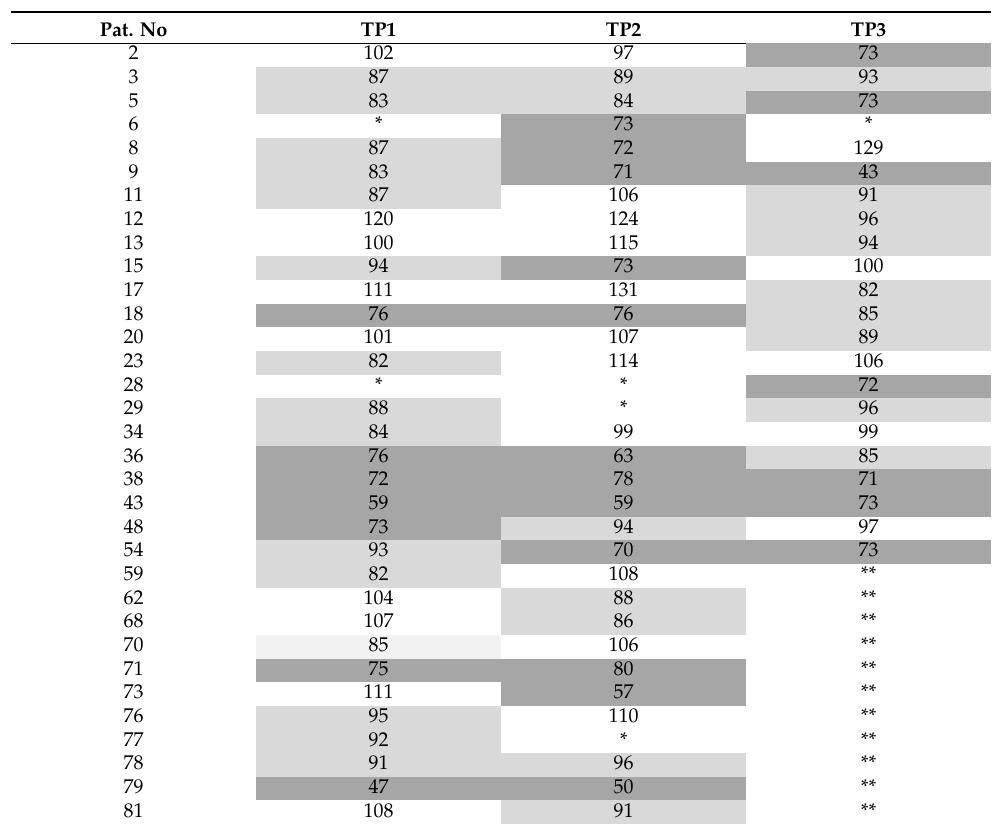
Table 14. SESA indicators over the